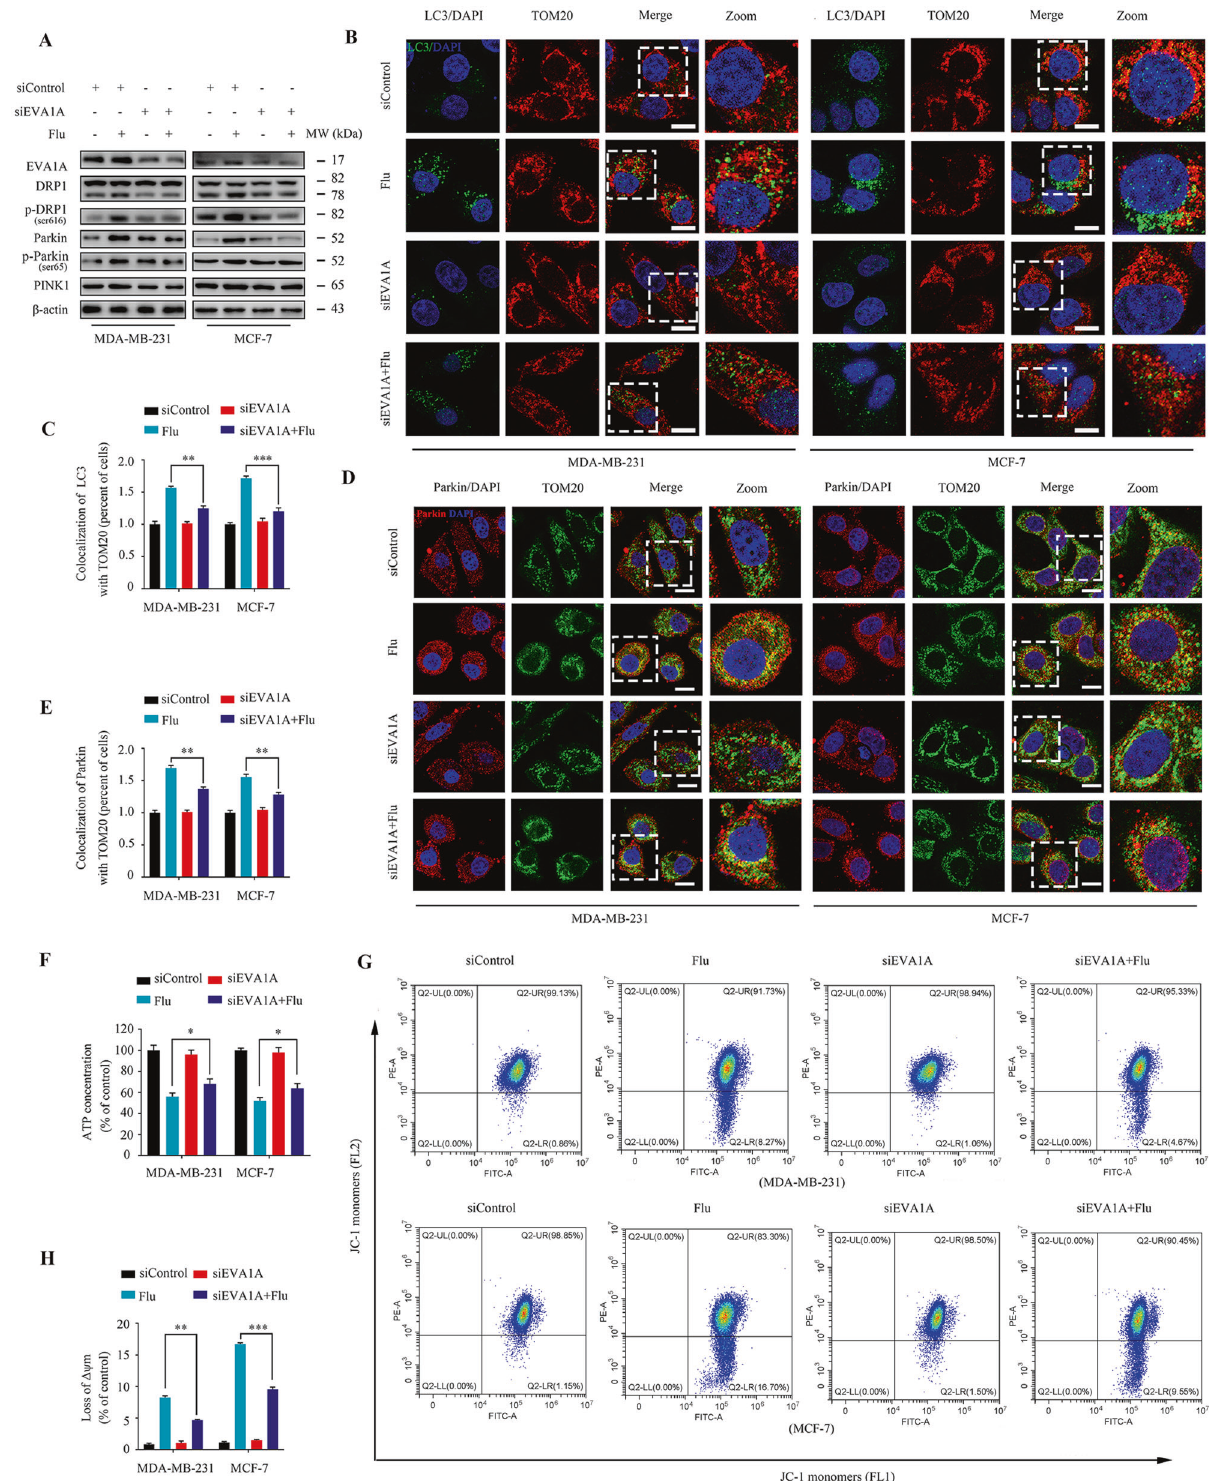
Fig. 6 Flubendazole induces mitochondrial dysfunction and DRP1-mediated mitophagy via targeting EVA1A in MDA-MB-231 and MCF-7 cells. MDA-MB-231 and MCF-7 cells were transfected with EVA1A siRNA or negative-control for 24 h, respectively, followed by treatment with or without fl ubendazole (0.5 μ M). A Immunoblotting of EVA1A, DRP1, p-DRP1 ser616 , Parkin, p-Parkin ser65 and PINK1 expression. β -actin was measured as the loading control. B , C The autophagosomes are labeled by LC3 (green fl uorescence) protein, and the mitochondria are labeled by TOM20 (red fl uorescence) protein. The number of co-localized LC3 and TOM20 was quanti fi ed. Scale bar, 10 µm. D , E Colocalization of Parkin (red fl uorescence) protein and TOM20 (green fl uorescence) protein in MDA-MB-231 and MCF-7 cells following fl ubendazole (0.5 μ M, 24 h) treatment. The number of co-localized Parkin and TOM20 was quanti fi ed. Scale bar, 10 µm. F ATP content measurement. G , H Flow cytometric analysis and quanti fi cation of mitochondrial membrane potential changes. Data represent mean ± SD. * P < 0.05, ** P < 0.01, *** P < 0.001. Statistical signi fi cance compared with respective control groups (all P -values were obtained by one-way ANOVA). Cell Death and Disease (2022)